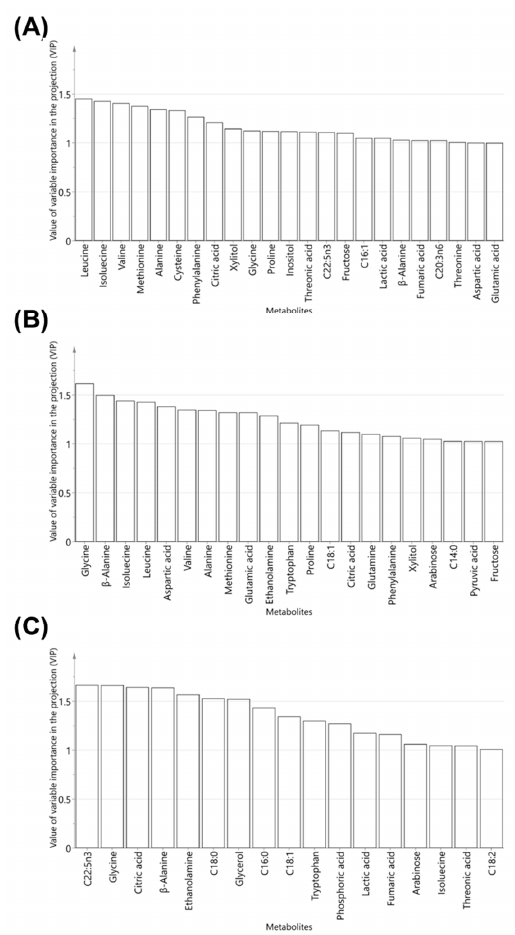
Figure 4. Variables important in the projection (VIP) plots of the orthogonal partial least squares discriminant analysis (OPLS-DA) models obtained from 49 metabolites in the serum of beagle dogs fed on a control, BG-M, or BG-H diet for 8 weeks. OPLS-DA models indicate regressions between the control and BG-M ( A ), control and BG-H ( B ), or BG-M and BG-H ( C ) groups. Metabolites with VIP values > 1.0 are presented in the VIP plots. Fatty acid formula is: C (number of carbon atoms): (number of double bonds) nx (position of double bonds). Control, a regular diet; BG-M, regular diet with a medium concentration of BG extract; BG-H, regular diet with a high concentration of BG extract; C14:0, myristic acid; C16:0, palmitic acid; C16:1, palmitoleic acid; C18:0, stearic acid; C18:1,